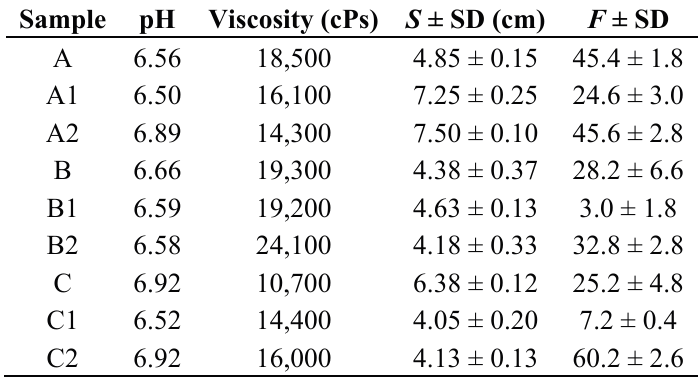
Table 3. Physicochemical properties, pH, viscosity, spreadability ( S ), occlusion factor ( F ), of emulsions